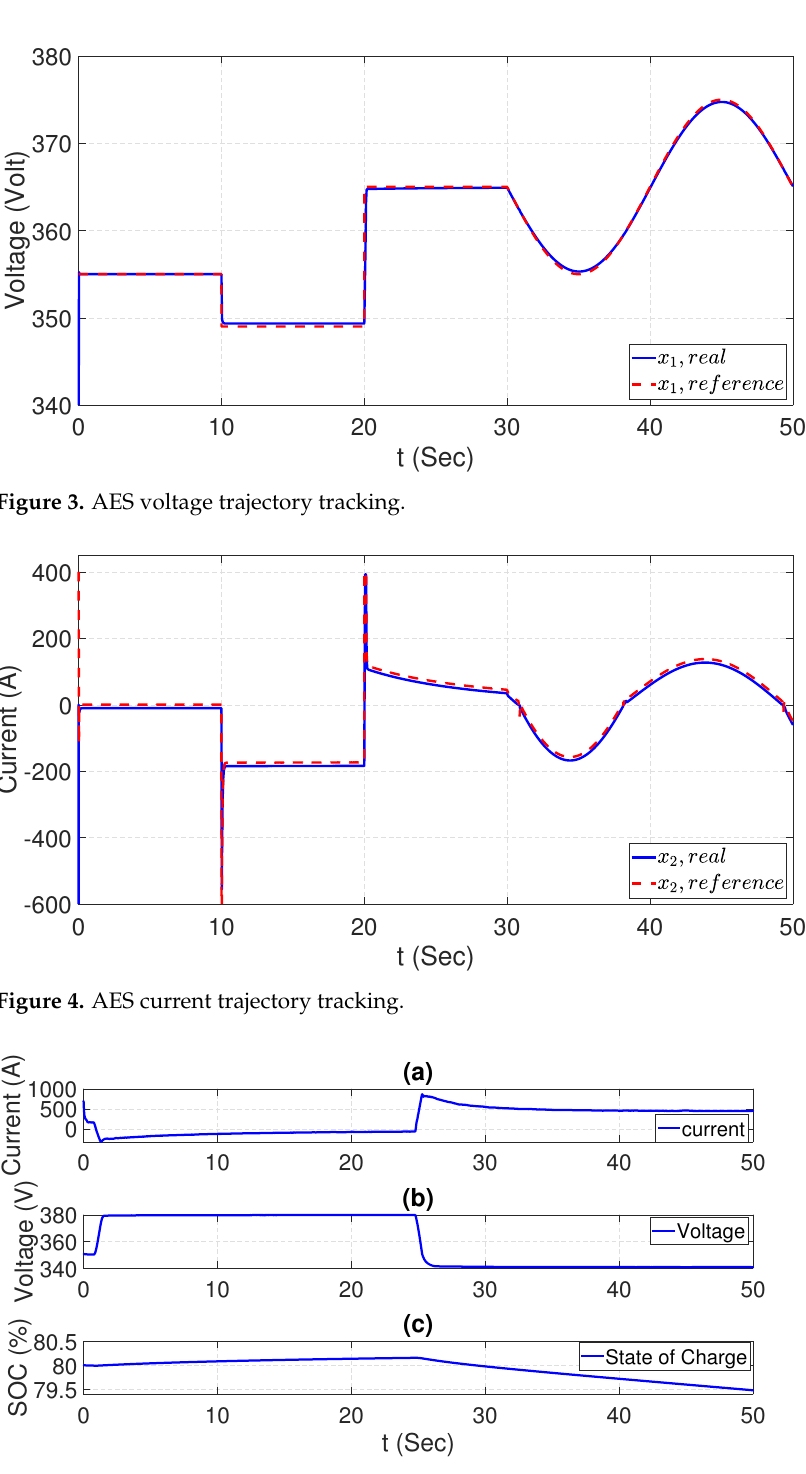
Figure 5. AES charging during trajectory tracking. ( a ) Illustrate the obtained current during the tracking operation, ( b ) the obtained voltage during the tracking operation and ( c ) the state of charge of the supercapacitor during the tracking operation. and